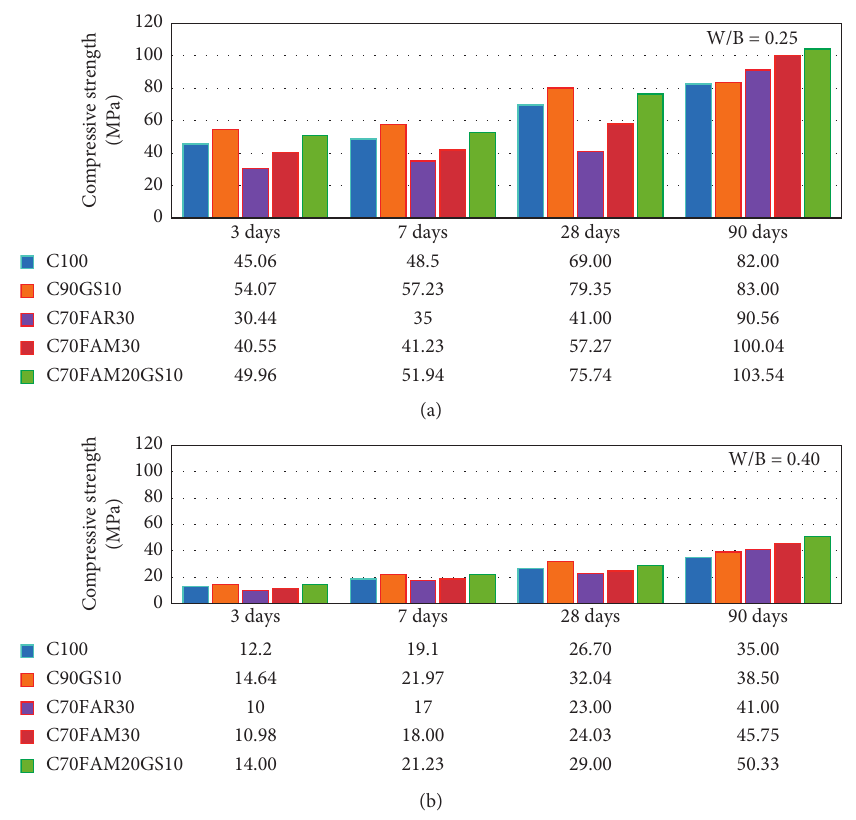
Figure 4: Compressive strength of specimens, before immersion in sulfuric acid solution. Compressive strength of mixtures with a W/B of (a) 0.25 and (b) 0.40.